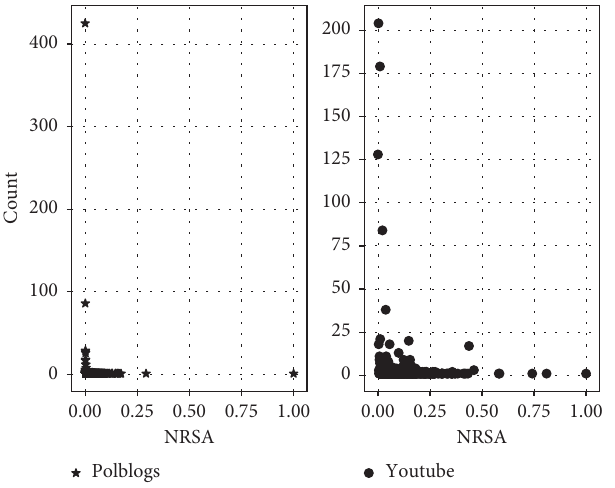
Figure 2: Node importance statistics of real dataset.